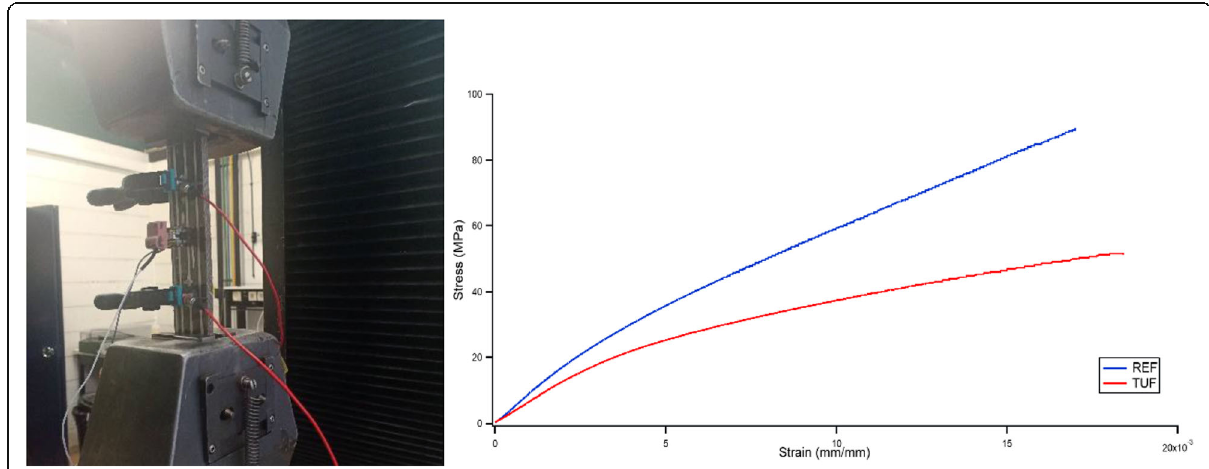
Fig. 14 a Graphic of specimen under tensile loading. b Stress vs strain curve of specimen under tensile loading